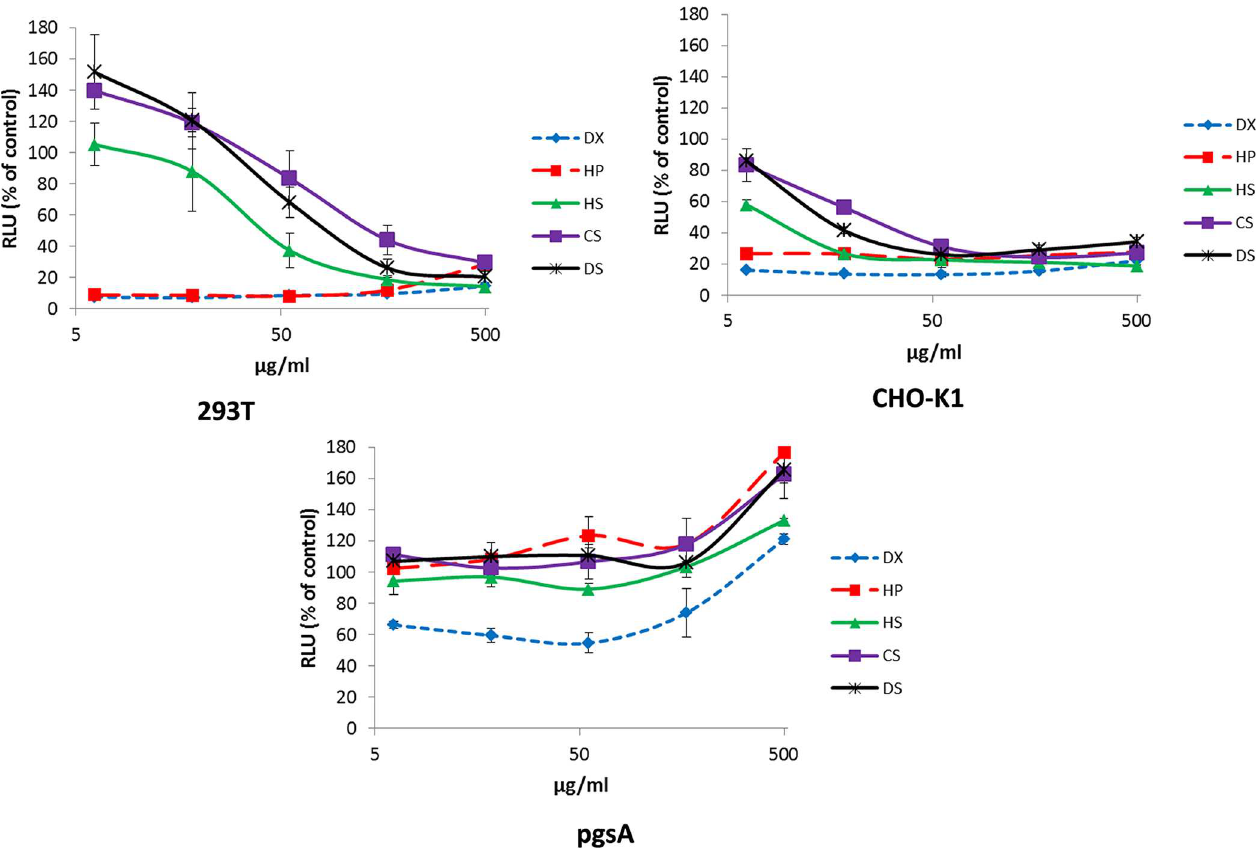
Fig 2. Transduction of cells with CHIKV Env pseudotyped vectorsin the presenceof soluble GAGs. 293T (left), CHO-K1 (right), and pgsA- 745 (bottom) cells were seeded in 384-well plates and transduced with CHIKV Env-pseudotypedvectors transferringa luciferase gene. Before additionto the cells, the vector particles were incubatedwith DX or one of the indicatedGAGs for 30 minutes at 4˚C (DX and GAGs in five 3-fold dilutions, rangingfrom 500.0 to 6.2 μ g/ μ l).One day after transduction, the luciferaseexpressionof the cells was detected by a luminometer [20]. The results are given as percentagesof the untreatedcontrol values. The experiment was carried out twice in triplicate, and one representative triplicateresult is shown.